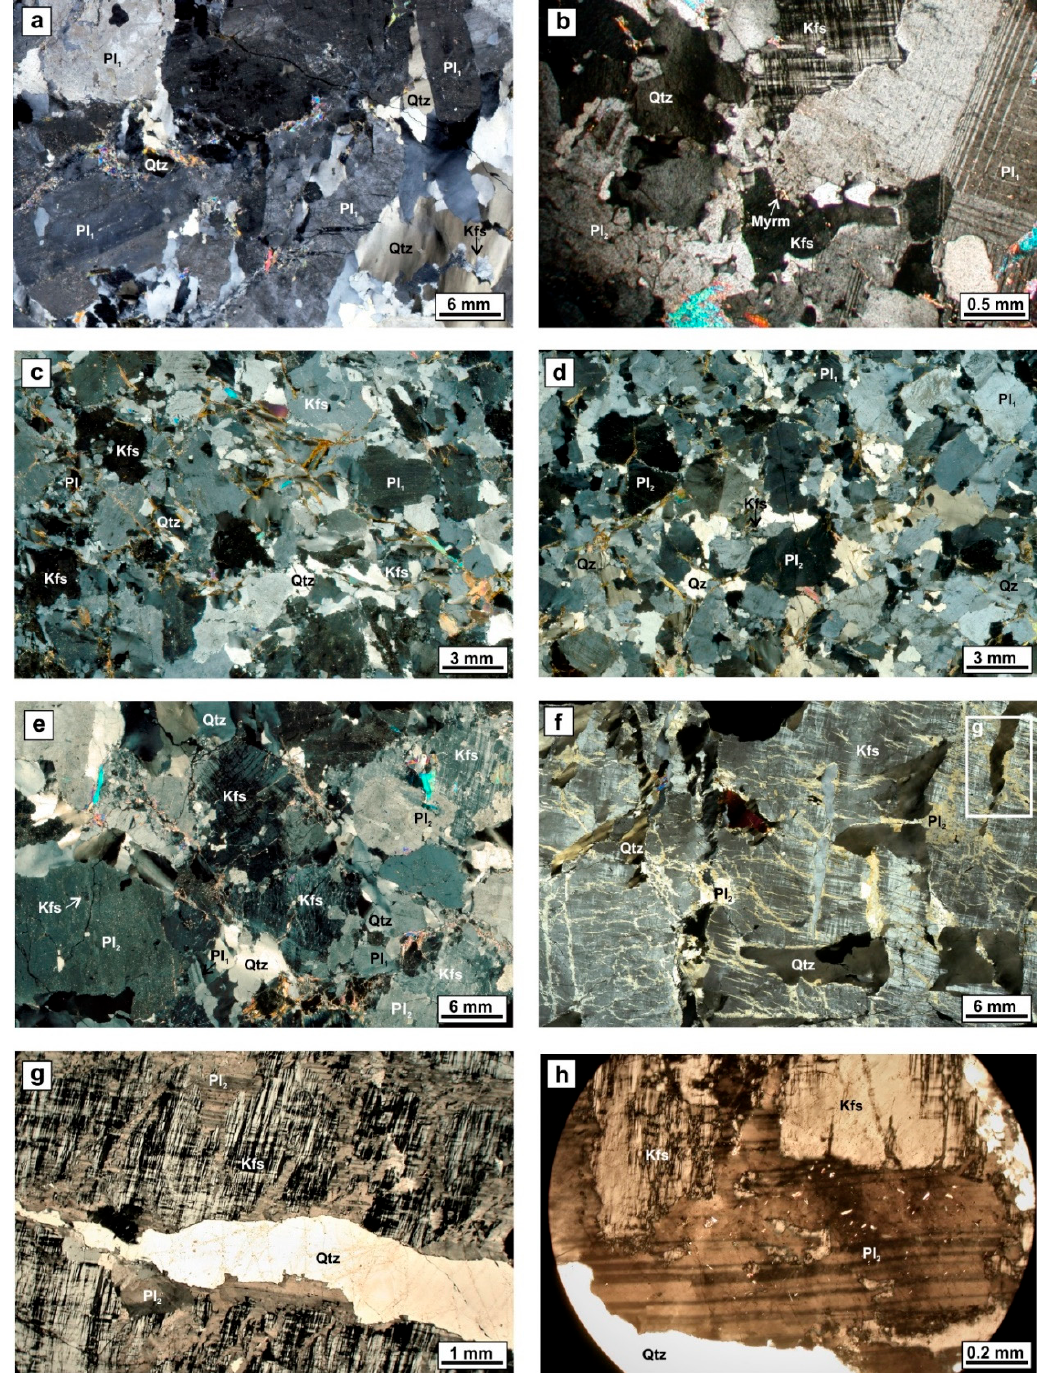
Figure 4. General petrographic features of the studied granitoids (crossed polars). Abbreviations: Pl, plagioclase; Qtz, quartz; Kfs, K-feldspar; Myrm, myrmekite. ( a ) Thin section scan of a trondhjemite sample showing the typical coarse- to very coarse-grained hypidiomorphic texture, with euhedral to subhedral plagioclase, subhedral micas and anhedral quartz and rare K-feldspar.; ( b ) Microdomain of trondhjemite sample with interstitial K-feldspar partly replaced by secondary plagioclase (Pl 2 ) and myrmekites; ( c ) Granite sample showing the dominant medium- to coarse grained hypidiomorphic texture with euhedral to subhedral plagioclase, subhedral micas, subhedral-anhedral K-feldspar (mainly orthoclase in this sample) and anhedral quartz; ( d ) Low-Ca (metasomatic) trondhjemite showing the same texture and mineral assemblage of the granite in ( c ), but with large amount of secondary plagioclase (Pl 2 ) formed by metasomatic replacement of the primary K-feldspar; e ) example of the coarse- to very-coarse grained variety of metasomatic trondhjemite with abundant turbid secondary plagioclase replacing large crystals of microcline; ( f ) very large relic crystal of microcline